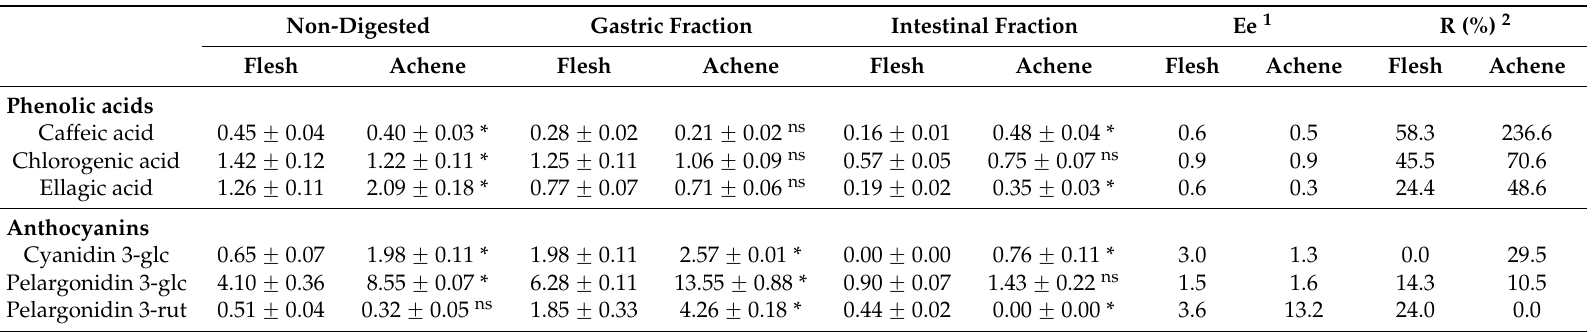
Table 3. Content (mg/g DW) of phenolic acids (caffeic acid, chlorogenic acid and ellagic acid) and anthocyanins (Cyanidin 3-glucoside, Pelargonidin 3-glucoside and Pelargonidin 3-rutinoside) in flesh (F) and achene (A) extracts before (non-digested) and after gastric (gastric fraction) and total digestion (intestinal fraction). All analyses were performed in triplicate. Data represent the mean ˘ Standard Error (SE). Post hoc comparisons were done by Tukey’s test. (*) and ( ns ) indicate significant ( p < 0.05) and non-significant differences,